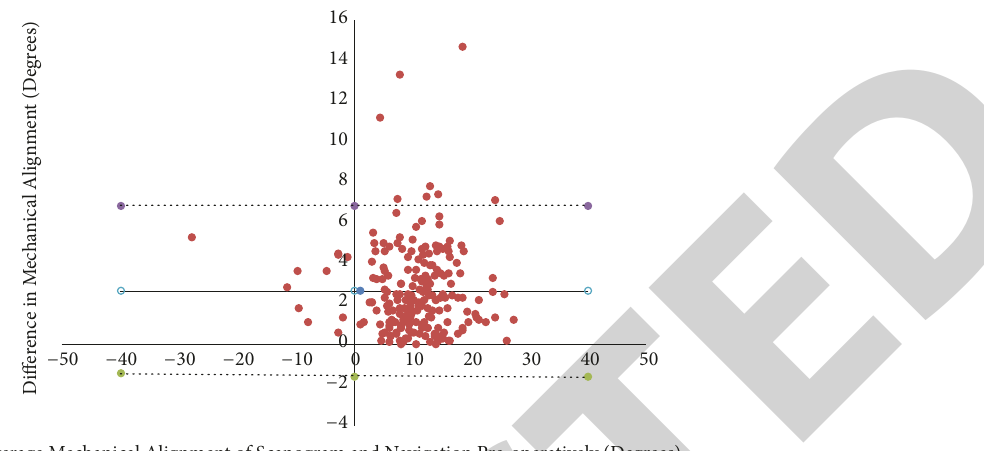
Figure 1: Bland-Altman plot showing relation between difference and mean of preoperative values of alignment.